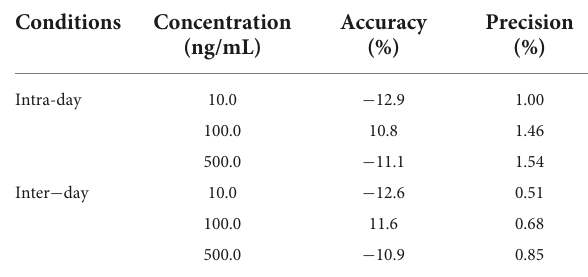
TABLE 3 Intra-day and inter-day assay precision and accuracy of FLC in C. albicans lysate samples ( n = 5).